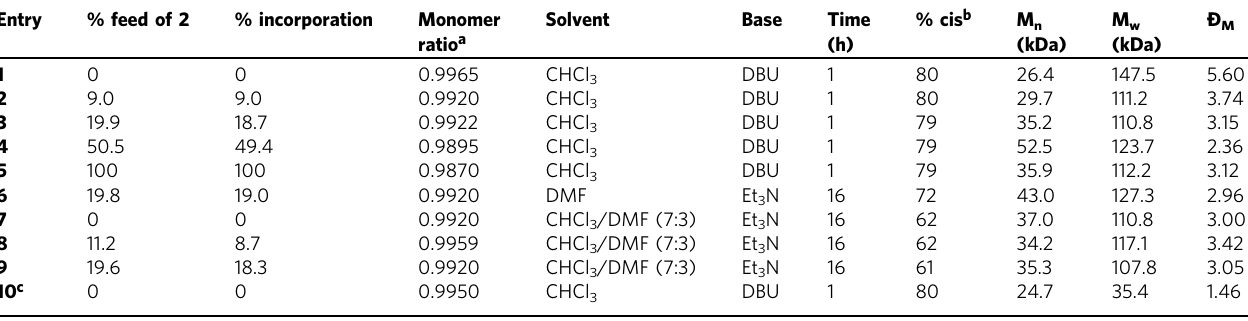
Table 1 Polymerization conditions and characterization of all thiol-yne step growth